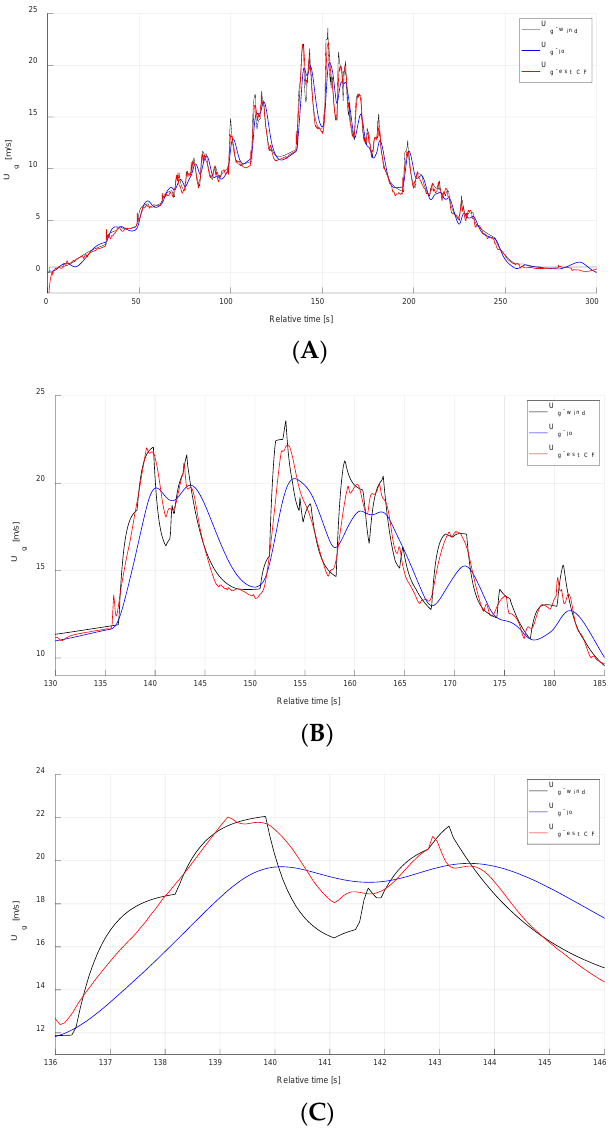
Figure 18. Comparison of the gust value with the estimation results (complementary filter, T c = 1 s, estimation delay reduced by 1 s)—flight crossing a gust area; ( A ) whole simulation, ( B ) several selected gusts, and ( C ) single selected gust.